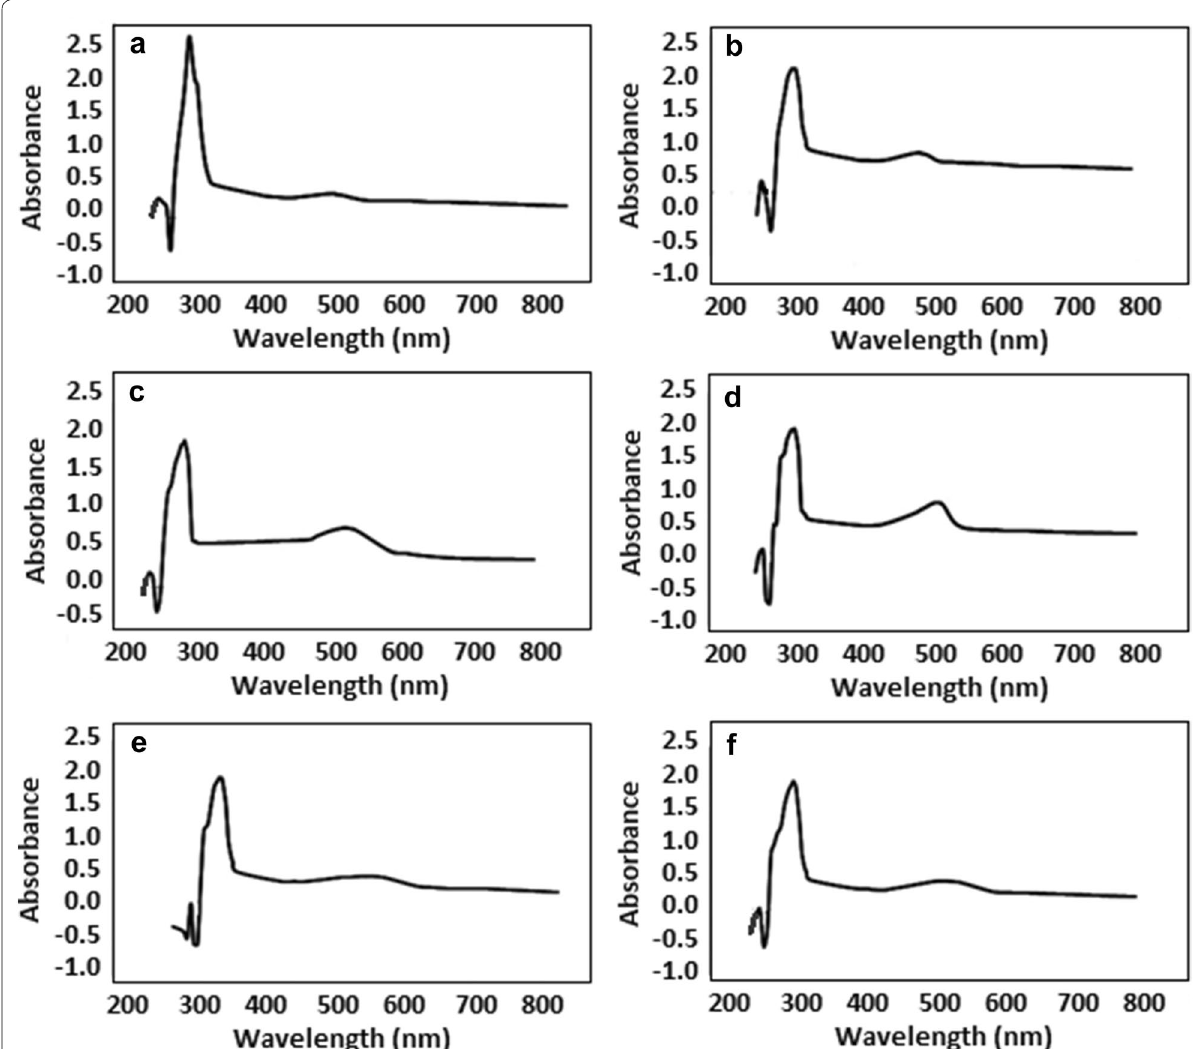
Fig. 3 UV–Visible spectra of a POC, and POC/Cr NCs containing b 1% Ni NPs, c 3% Ni NPs, d 5% Ni NPs, e 7% Ni NPs, f 10% Ni